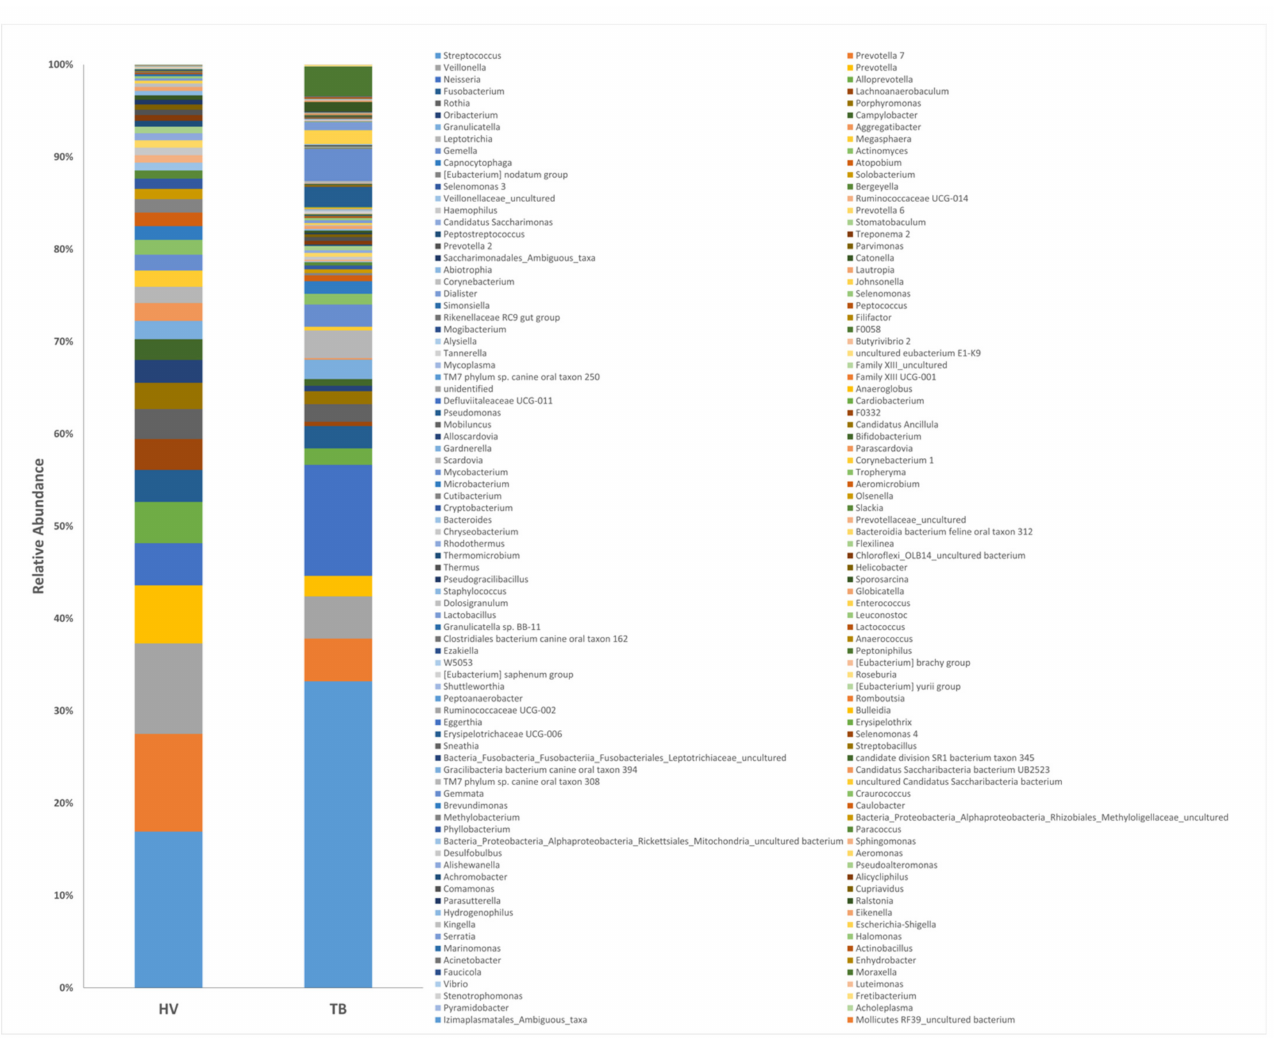
Figure 4. Composition of the dominant genera in the sputum of TB patients and healthy volunteers. 16S rRNA hypervariable regions V3–V4 from sputum samples were sequenced, and the relative abundance of genera is